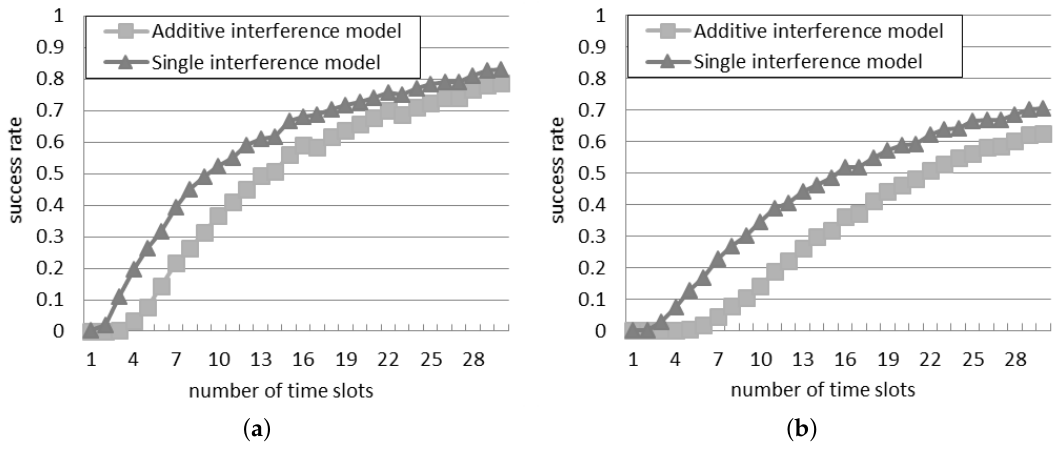
Figure 5. Success rate in the slotted interrogation scenario: ( a ) 30 readers; ( b ) 50 readers.